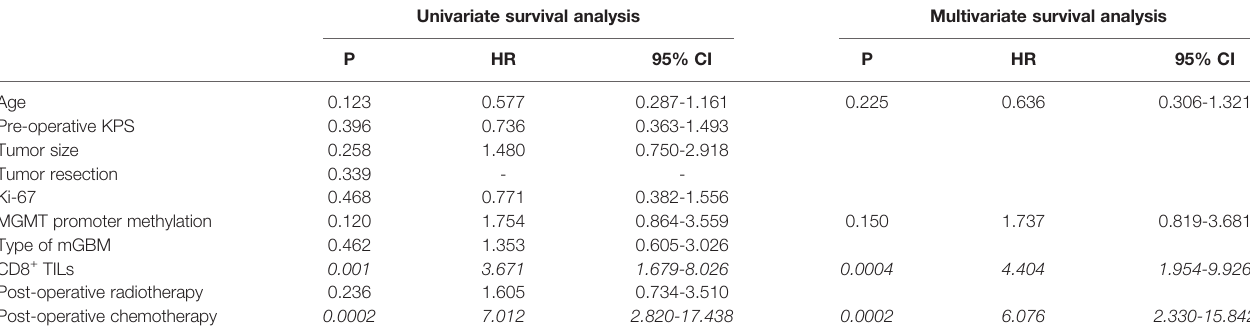
TABLE 4 | Univariate and multivariate analyses of different prognostic parameters for overall survival of 57 mGBM patients. Univariate survival